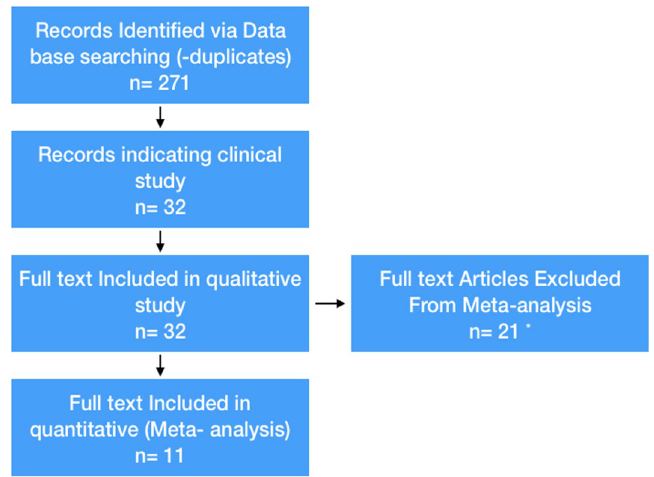
Figure 3. Flow diagram of included studies for meta-analysis of memory improvements caused by B . monnieri in healthy individuals. *Texts excluded for 1. Multiple herbs included in study 2. Acute study lasting less than six weeks 3. Inappropriate dose used 4. No randomization 5. No control groups 6. Study investigated pharmacological activities other than